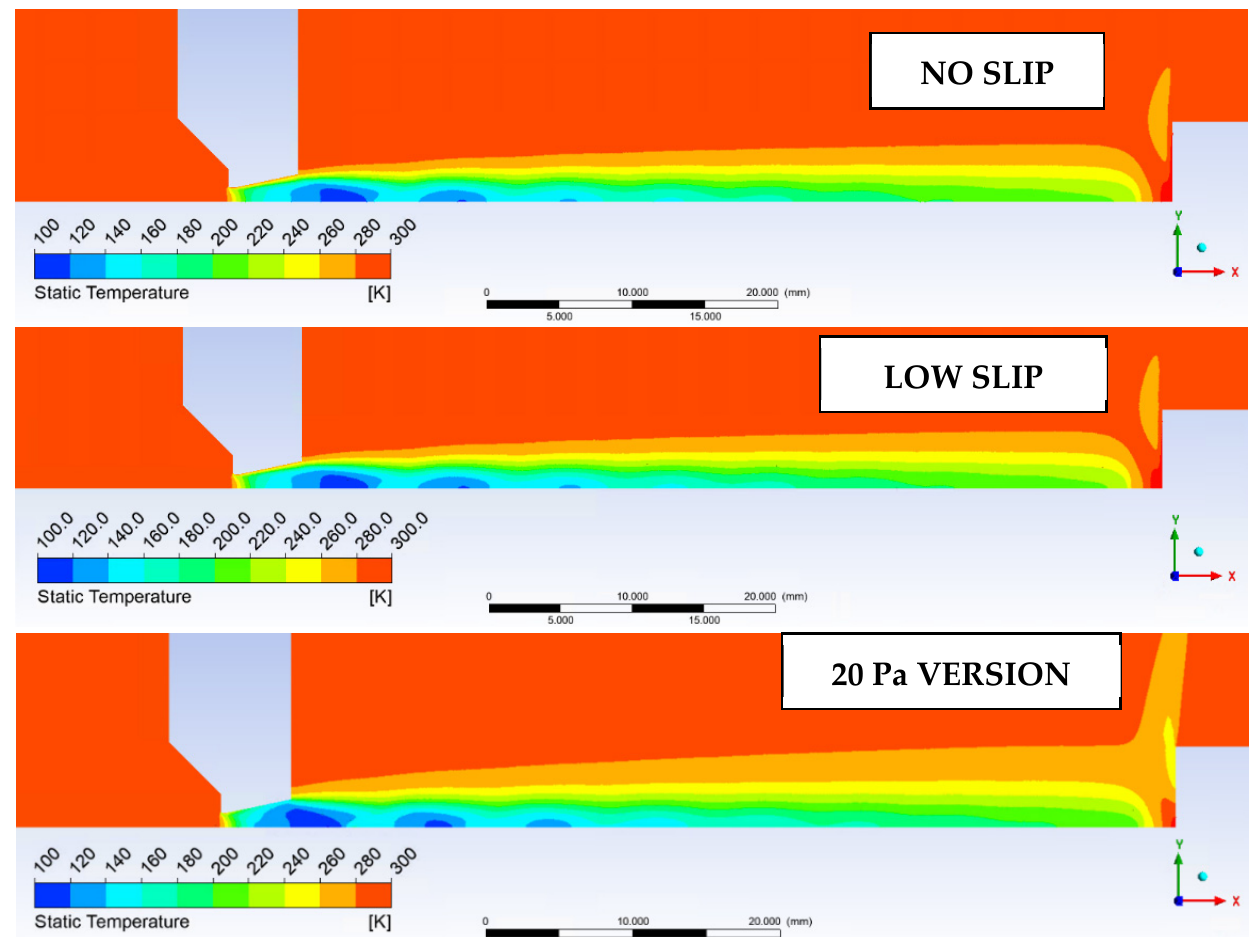
Figure 22. Static temperature evolution for the tested variants.